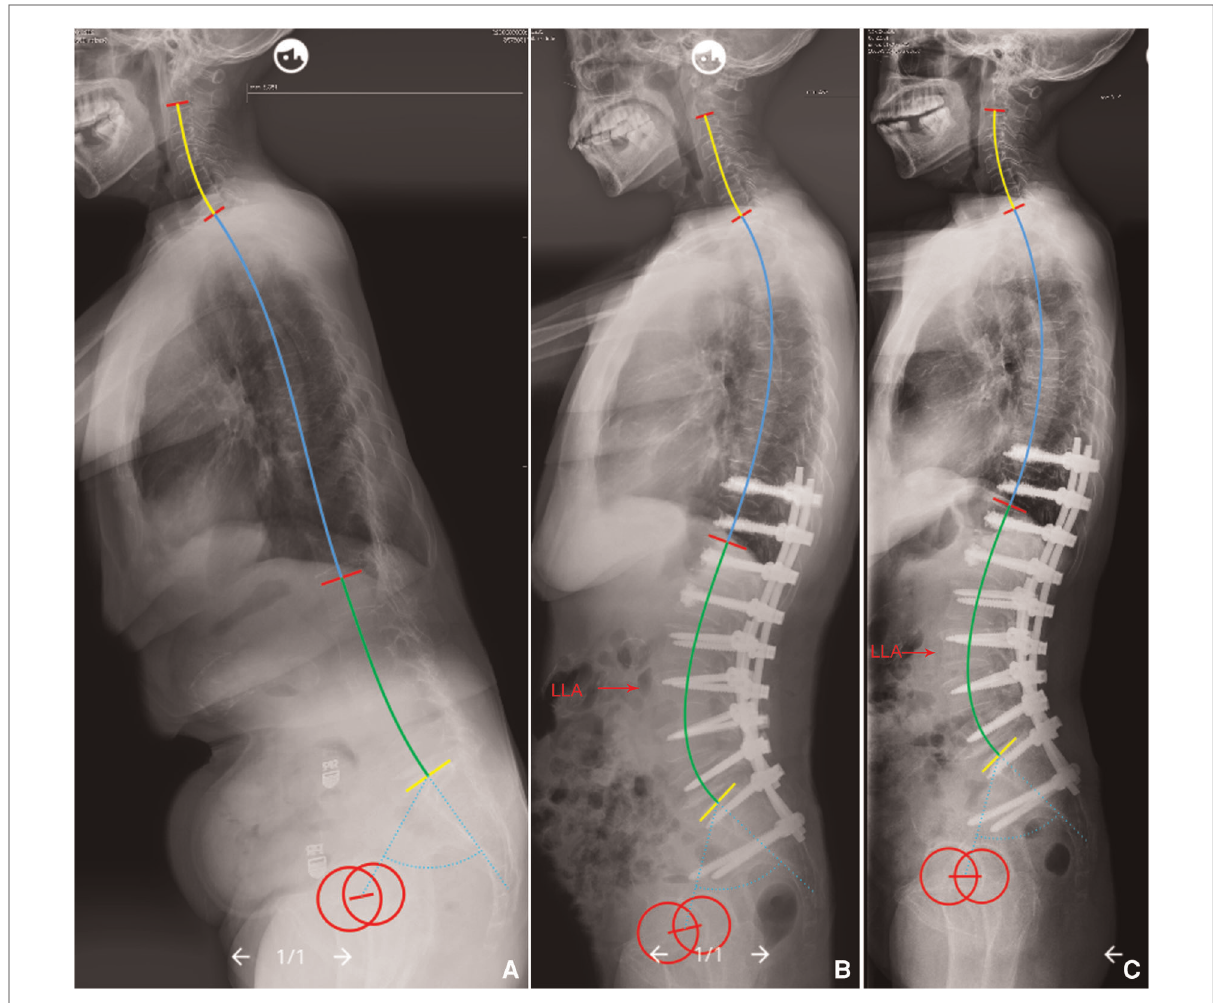
FIGURE 6 (A ) A 68-year-old female with global kyphosis, PI=63.2°. We planned to choose T11/12 as the IP, so that the LLA should be predicted to be L3 (ideal LLA=0.23*11.5 − 0.03*63.2+14.45=15.2), ideal LASO=0.38*63.2 − 2.09*11.5+53.62=53.6 mm, and the LLL should be corrected to be 45.4° (ideal LLL=0.58*63.2 − 0.88*11.5+18.86=45.4°), and the ULL should be corrected to be 20°. ( B ) Immediate postoperative x-rays, actual LLA (L3), LASO (57.4 mm), LLL (46.2°), and ULL (20.1°) were nearly equal to the theoretical values. ( C ) No mechanical complications at the 2-year follow up. PI, pelvic incidence; IP, in fl ection point; LLA, apex of lumbar lordosis; LASO, the horizontal offset between the plumb line of the lumbar apex and that of the posterosuperior corner of S1; LLL, lower lumbar lordosis; ULL, upper lumbar